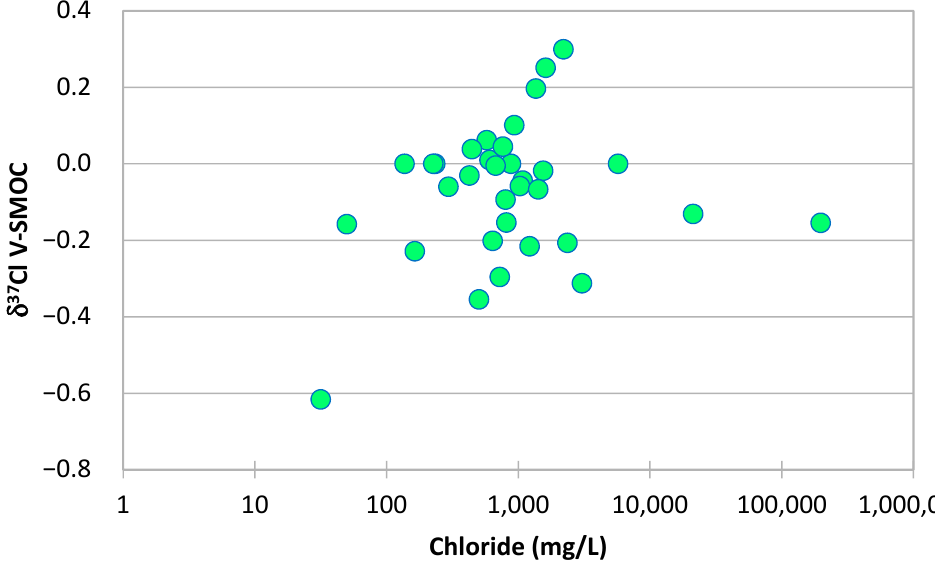
Figure 12. Plot of δ 37 Cl ‰ (SMOC) vs. Cl − [23].